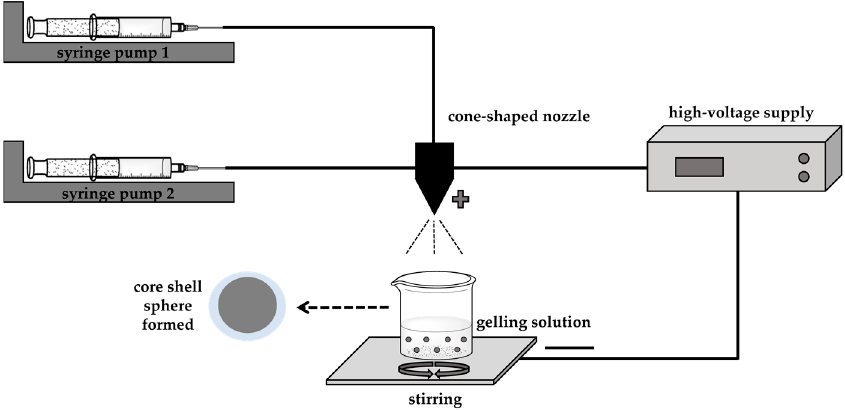
Figure 15. Schematic representation of microencapsulation process by coaxial electrospraying